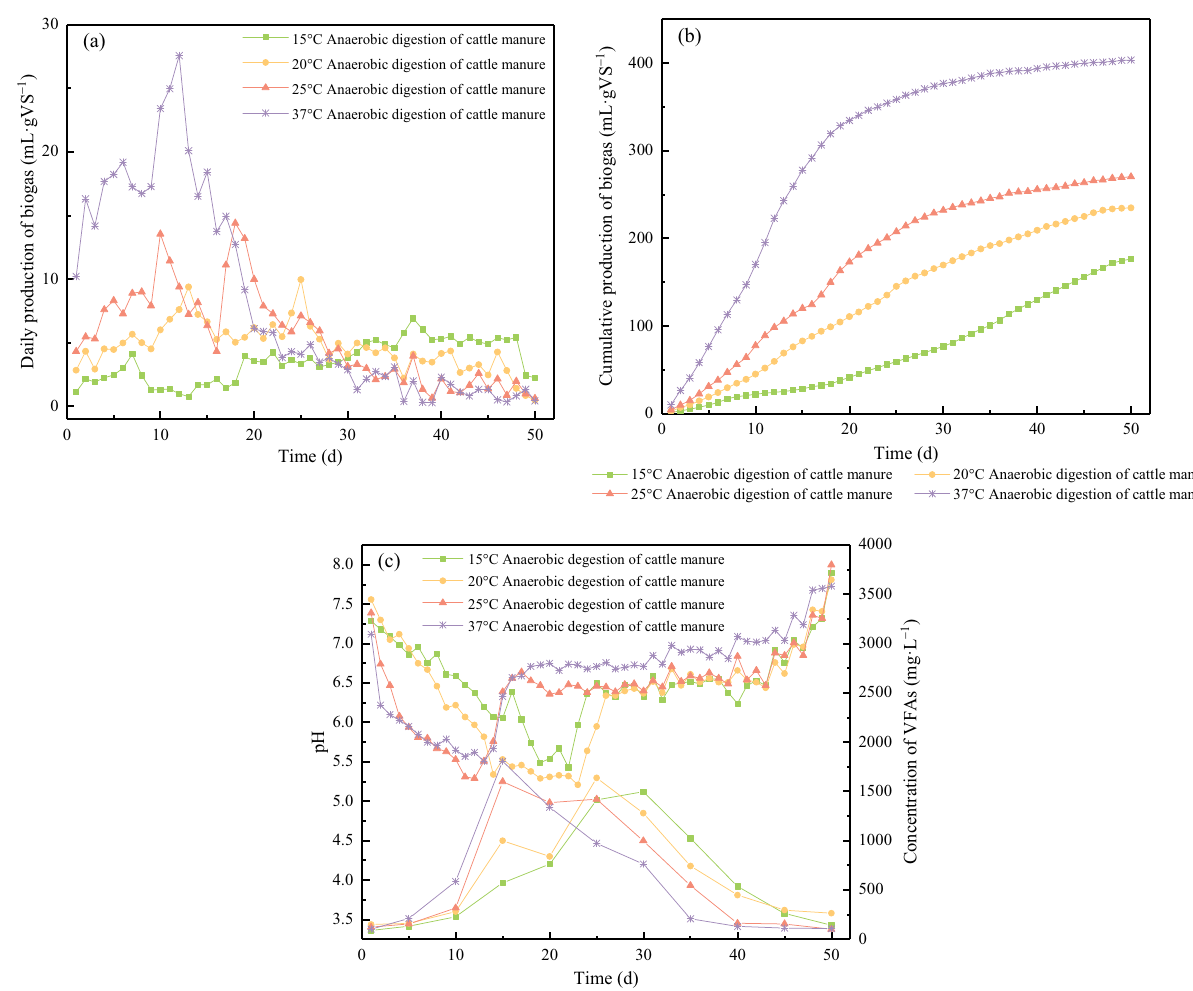
Figure 2: Analysis of physical and chemical properties of fermentation broth in the anaerobic digestion of cattle manure at sub - mesophilic temperatures. Daily production of biogas ( a ) , cumulative production of biogas ( b ) , and pH ( c )